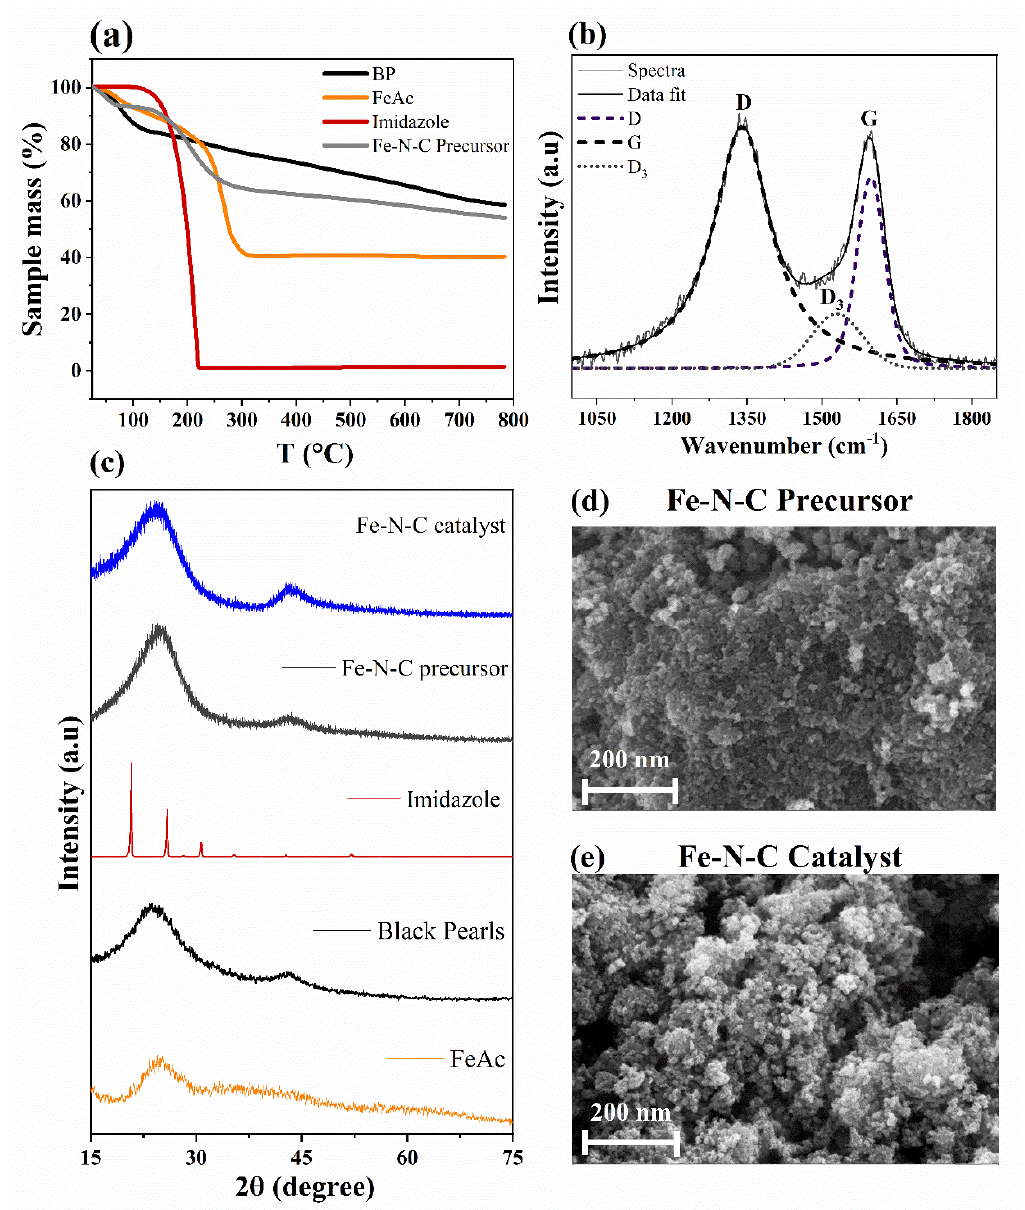
Figure 1. Thermogravimetric analysis of carbon black pearls, iron acetate, imidazole, and Fe-N-C precursor before pyrolysis treatment ( a ); Raman spectra and curve fitting of the Fe-N-C catalyst ( b ); XRD patterns for the Fe-N-C catalyst (Blue) and Fe-N-C precursor (Gray), imidazole (Red) carbon black pearls (Black), and iron acetate (Orange) ( c ) and, SEM image for the Fe-N-C materials before ( d ) and after ( e ) pyrolysis under ammonia atmosphere.